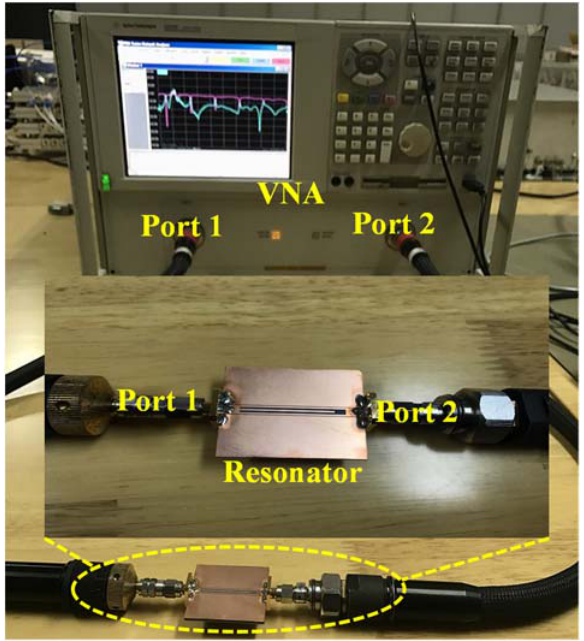
Figure 2. Measurement setup with the fabricated UGCPW embedded resonator.